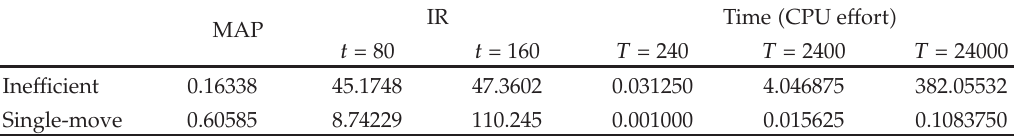
Table 1: Comparison between the e ffi cient and ine ffi cient MCMC simulator.